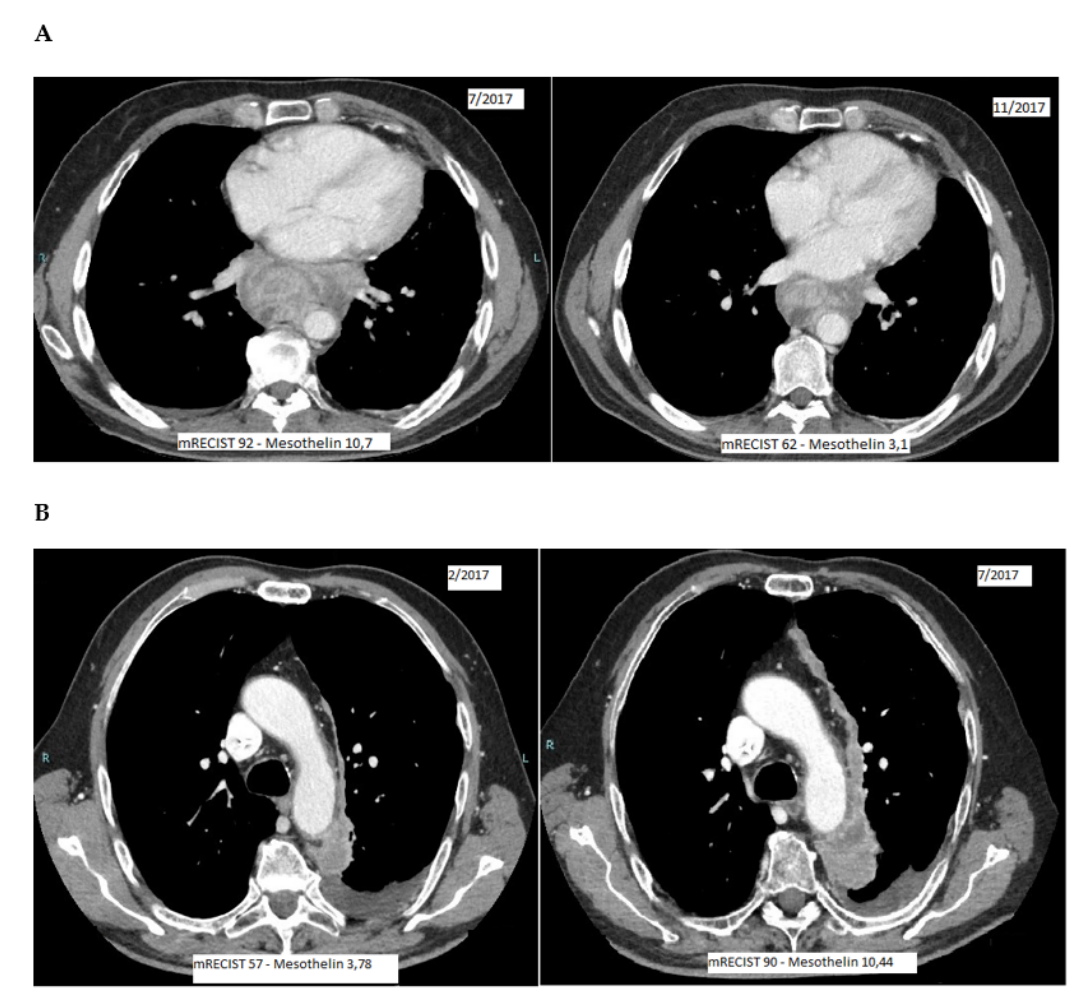
Figure 2. Examples of correlation between mRECIST score and SMRP levels. ( A ) mRECIST reduction (disease treatment response) correlates with SMRP reduction; ( B ) mRECIST increase (disease progression) correlates with SMRP increase; mRECIST: modified RECIST; SMRP: soluble mesothelin-related peptides.